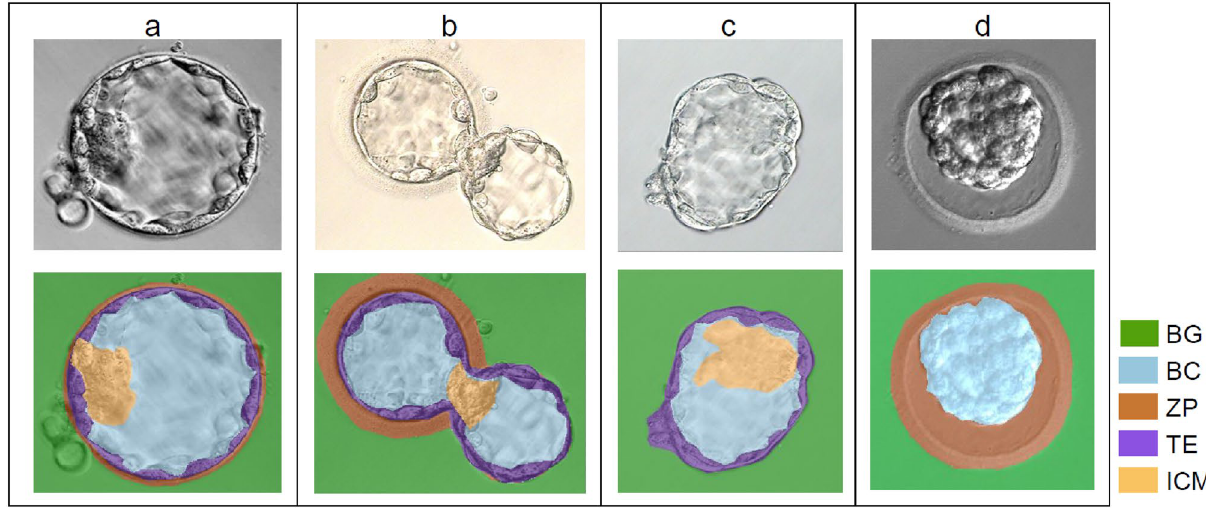
Figure 1. Examples of the blastocycst structures at each developmental stage, expansion ( a ), hatching ( b ), hatched ( c ) and collapsed ( d ). Colours indicate the regions of interest in the micrograph: background(BG), blastocoel (BC), zona pellucida (ZP), trophectoderm (TE), and the embryoblast or inner cell mass